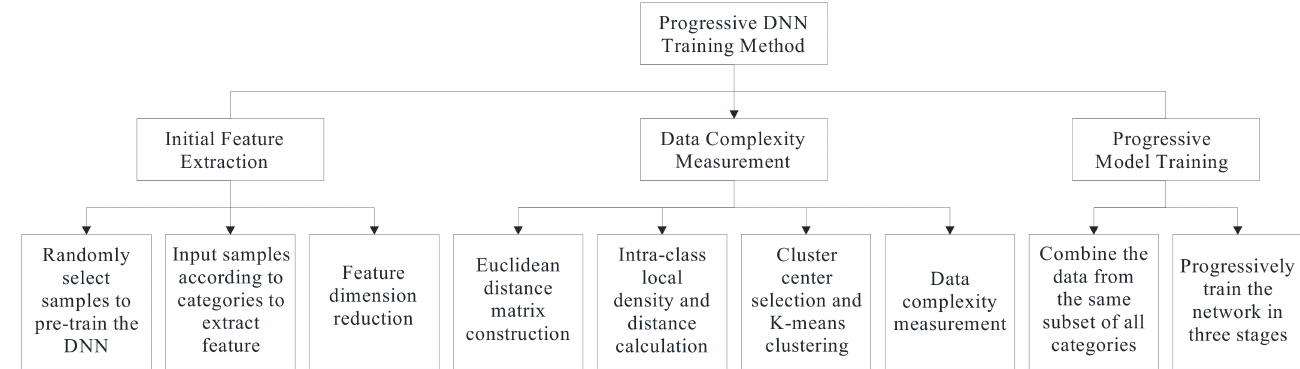
Figure 1. An overview of the proposed